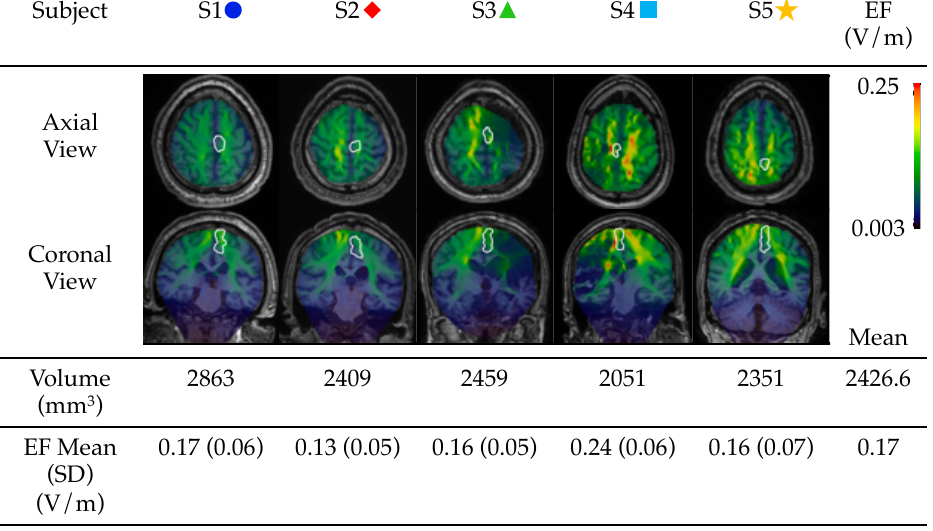
Figure 2. tDCS Electric Field Model. Representative axial and coronal slices showing the electric field (EF) near the leg M1 region (outlined in white) for each user. Within the M1 region, the volume and mean EF are shown.